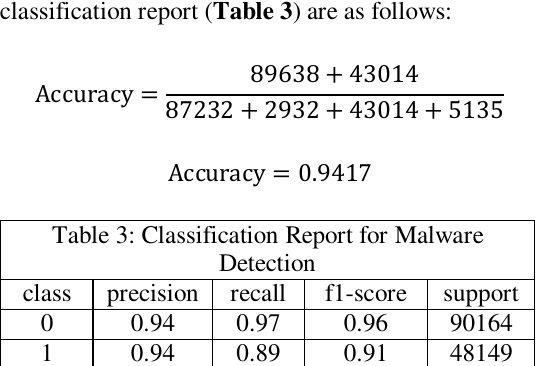
Fig.6: Confusion Matrix for Malware Classification